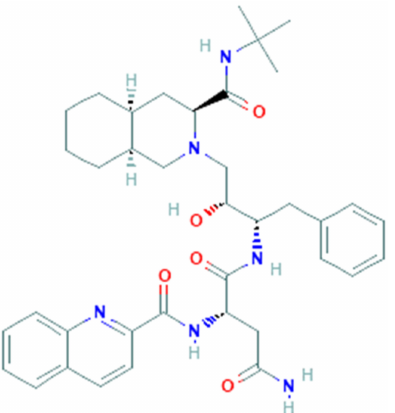
Figure 4. Chemical structure of